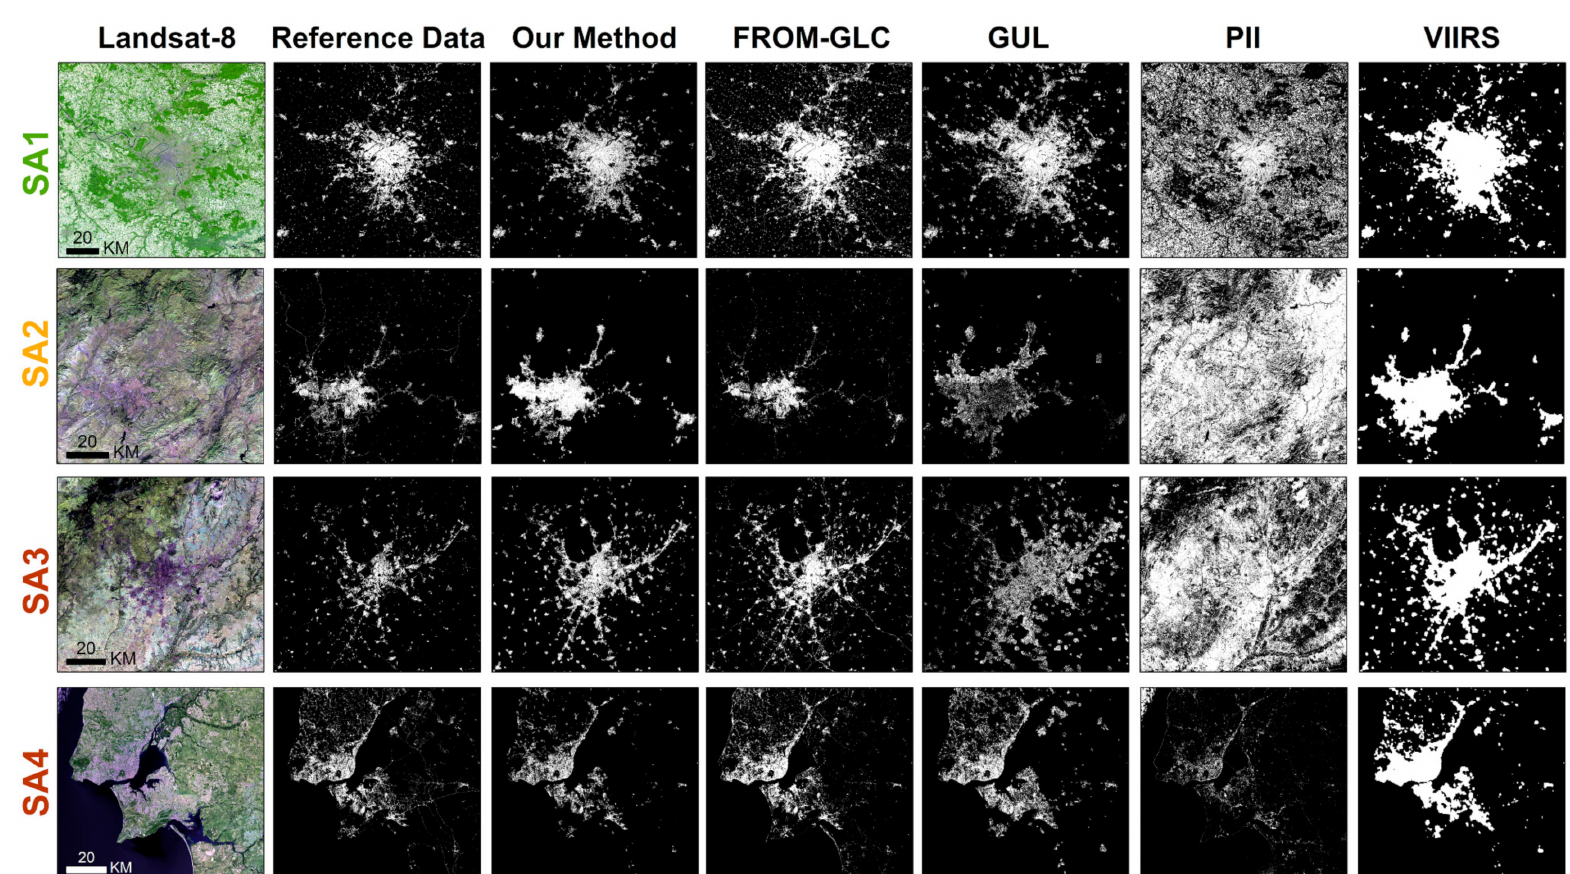
Figure 4. Comparison of results of the extraction of built-up areas according to di ff erent methods. The first column shows the Landsat-8 remote-sensing images (RG6B4); the second column shows the HRL IMD2015 reference data; the third column shows the built-up area extraction results using our method, and the fourth through seventh columns show the built-up area results for FROM-GLC, GUL, PII, and